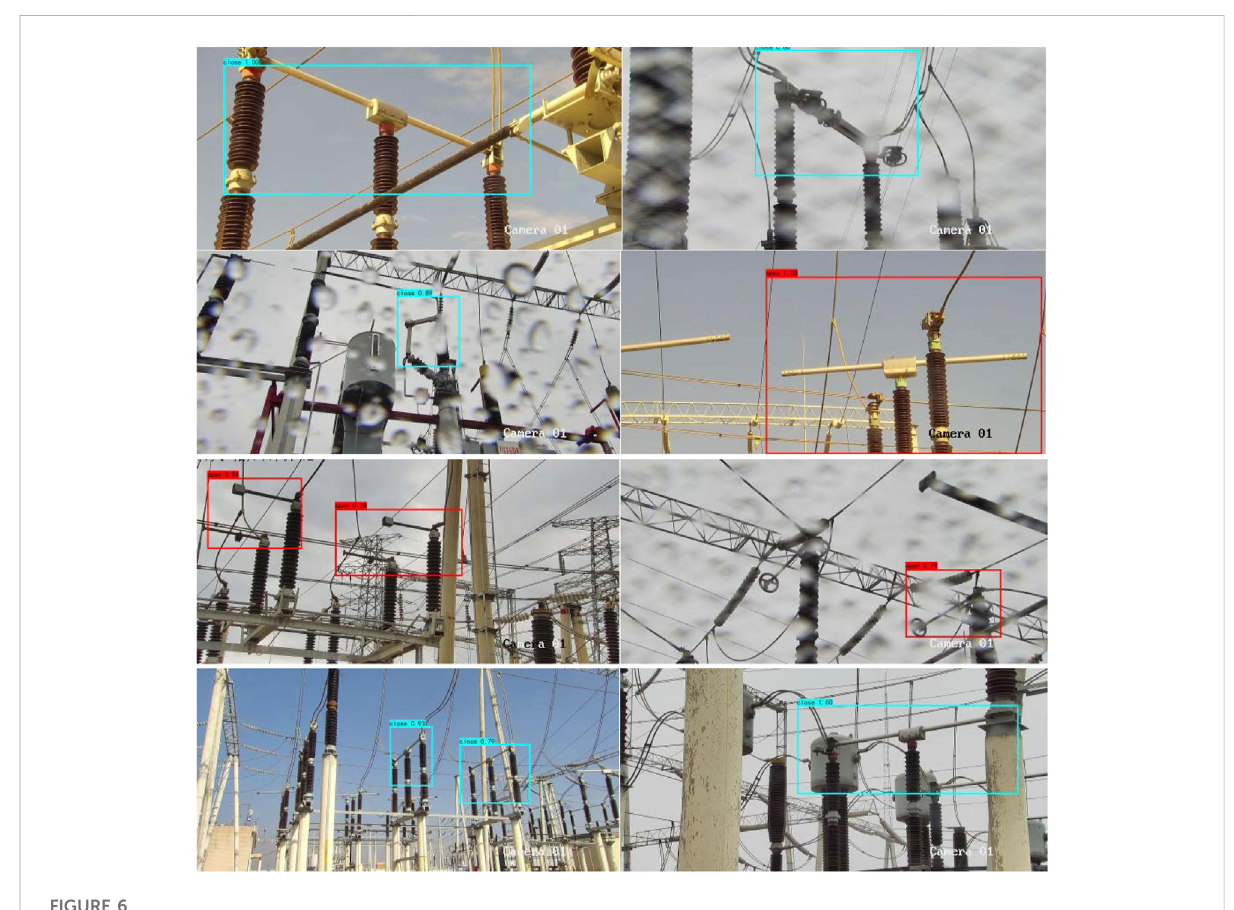
FIGURE 6 Isolation switch identi fi cation result